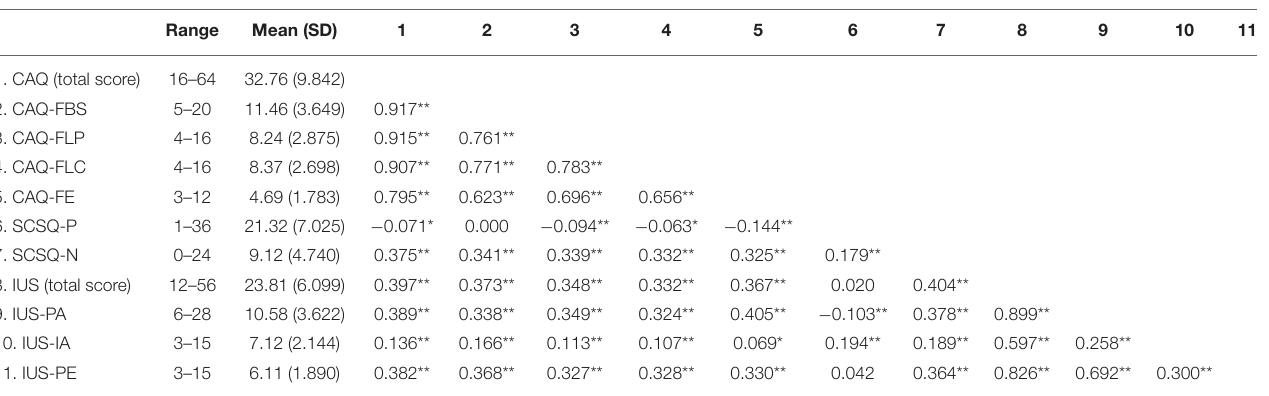
TABLE 2 | Pearson correlation analysis and descriptive statistics of main